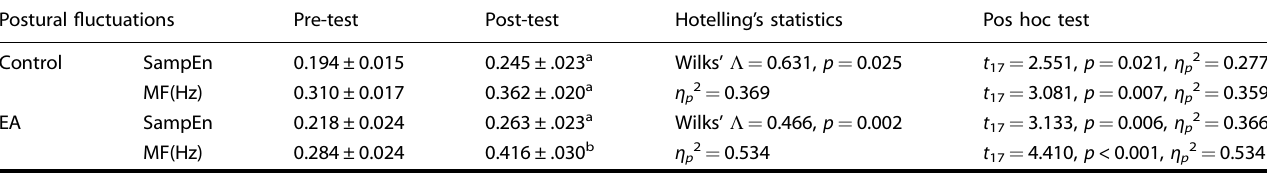
Table 1. The comparison of postural fl uctuation properties (sample entropy (SampEn) and mean frequency (MF)) between the pre-test and post-test for the error ampli fi cation (EA) and control